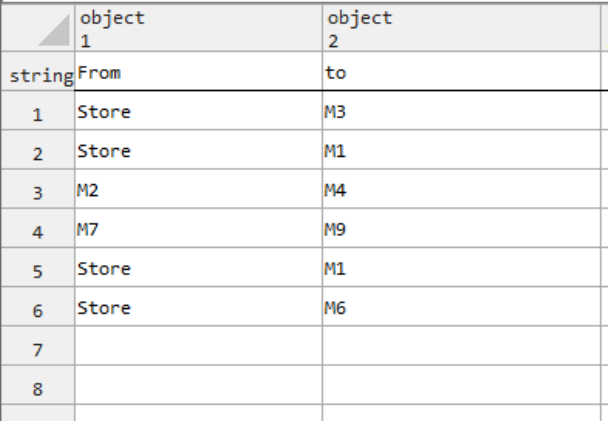
Figure 13. Dynamic task lists.